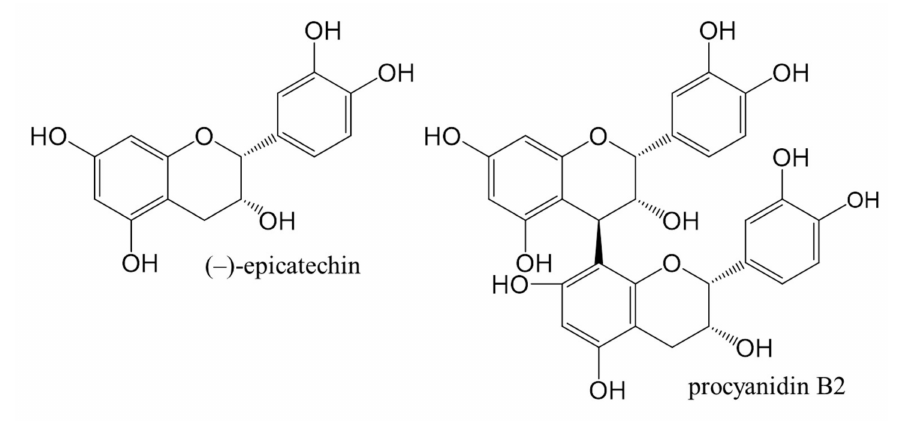
Figure 1. Chemical structures of ( − )-epicatechin and procyanidin B2 standards used in this